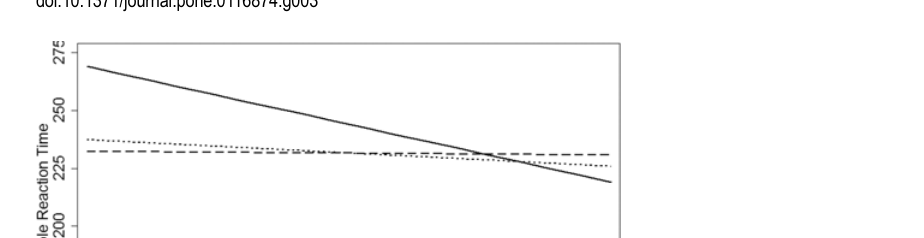
Figure 3. Model-based Prediction of the Serial Digit Learning Test Illustrating the Interaction of Gender and Race-Ethnicity with H. pylori and CagA. Panel A presents model-based predictions (Table 5, Model 1) of the interaction of gender with H. pylori and CagA on the Serial Digit Learning Test (SDL) controlling for latent toxoplasmosis, age, race-ethnicity, PIR, education, health, and hemoglobin. Higher values indicate poorer cognitive function on SDL. Panel B presents model-based predictions (Table 5, Model 2) of the interaction of race-ethnicity with H. pylori and CagA on the Serial Digit Learning Test (SDL) controlling for latent toxoplasmosis, age, gender, PIR, education, health, and hemoglobin. Higher values indicate poorer cognitive function on SDL.